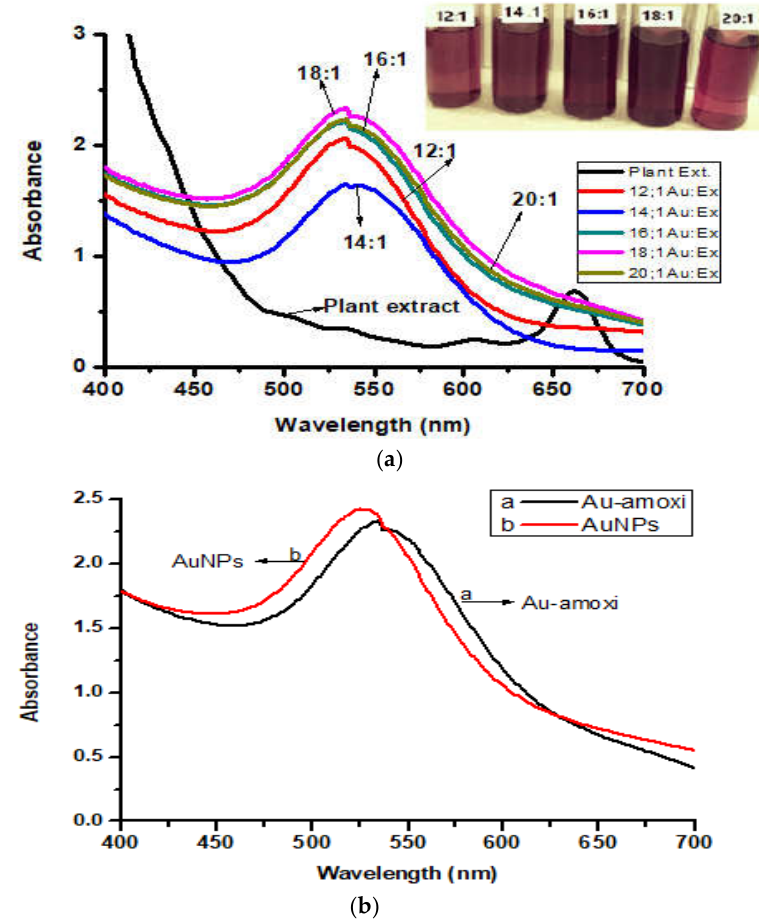
Figure 1. ( a ) Uv–visible spectra of AuNPs synthesized using flavonoid extract of Micromeria biflora . ( b ) Uv–visible spectra of Au - amoxi conjugate. ( b ) Uv–visible spectra of Au-amoxi